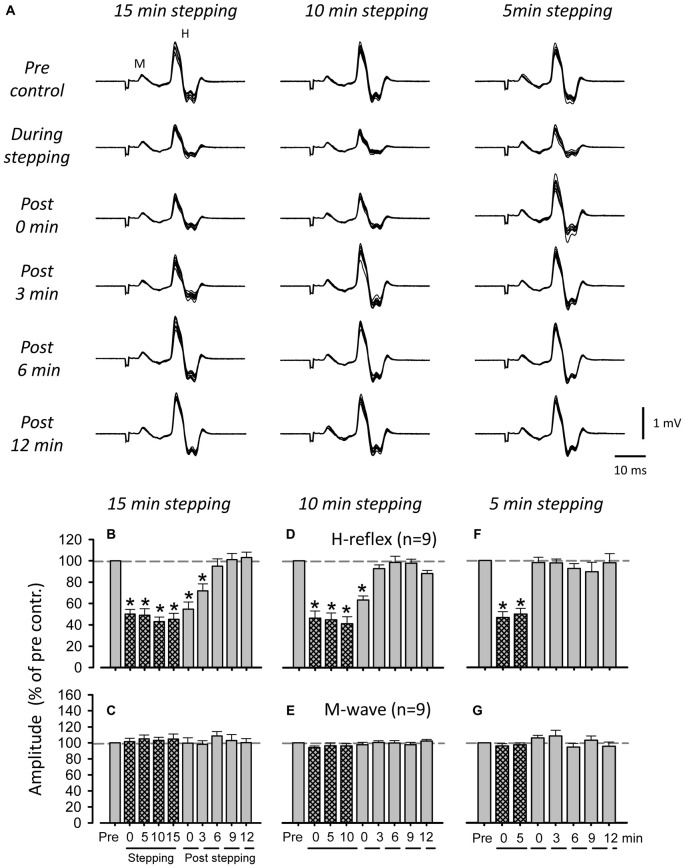
Influence of passive stepping duration on FCR H-reflex amplitudes. (A) Typical superimposed recordings (10 sweeps) of FCR H-reflex waveforms at 15 (left), 10 (center), and 5 min (right) of passive DGO stepping (40% unloading of body weight). Grand means (±SEM) of the magnitude of the H-reflex (B,D,F) and M-wave (C,E,G) in the FCR muscle obtained from nine subjects at 15 (left), 10 (center), and 5 min (right) of passive stepping (40% unloading of body weight). For each condition, FCR H-reflex waveforms were recorded every 5 min during stepping and every 3 min after stepping. *p < 0.01.